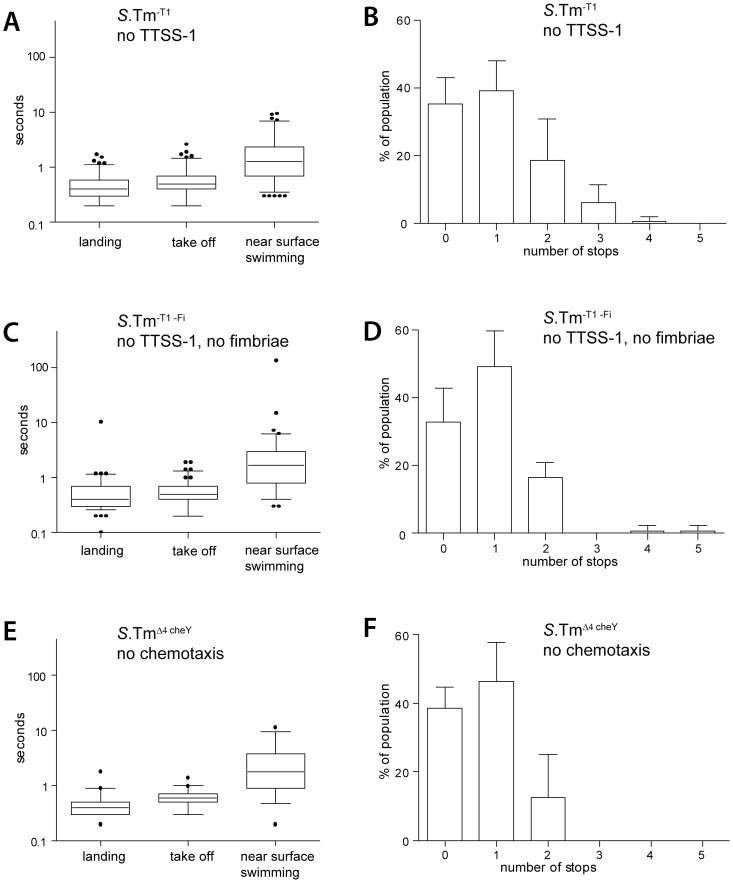

S. Typhimurium NSS does neither require adhesins nor chemotaxis.Quantitiative analysis of the initial host-cell interaction byS.Tm-T1(pGFP), S.Tm-T1-Fi(pGFP) and S.TmΔcheY(pGFP), lacking either the TTSS-1 apparatus,TTSS-1 and type 1 fimbriae or the four effectors SopE, SopE2, SopB and SipA as well as the protein CheY, essential for chemotaxis. (A), (C), (E)Different stages of NSS were quantified as described for Fig. 1D.The following numbers of bacteria were analyzed: S.Tm-T1(pGFP), n = 114; S.Tm-T1-Fi(pGFP),n = 91;S.TmΔcheY(pGFP), n = 39.Time-lapse microscopy data was derived from 2 to5independent experiments. (B), (D), (F) Numbers of stops by an individual bacterium were quantified as described in Fig. 1E.